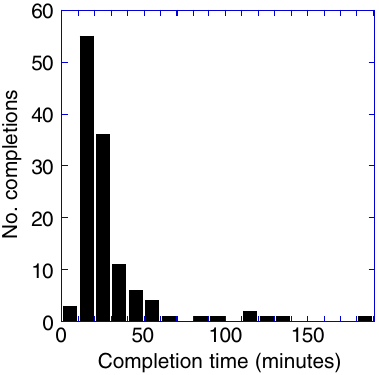
FIG. 6. Histogram of completion times for one particular type 1 coach. The average completion time was calculated using only the times that were within the main distribution (less than 70 min.).